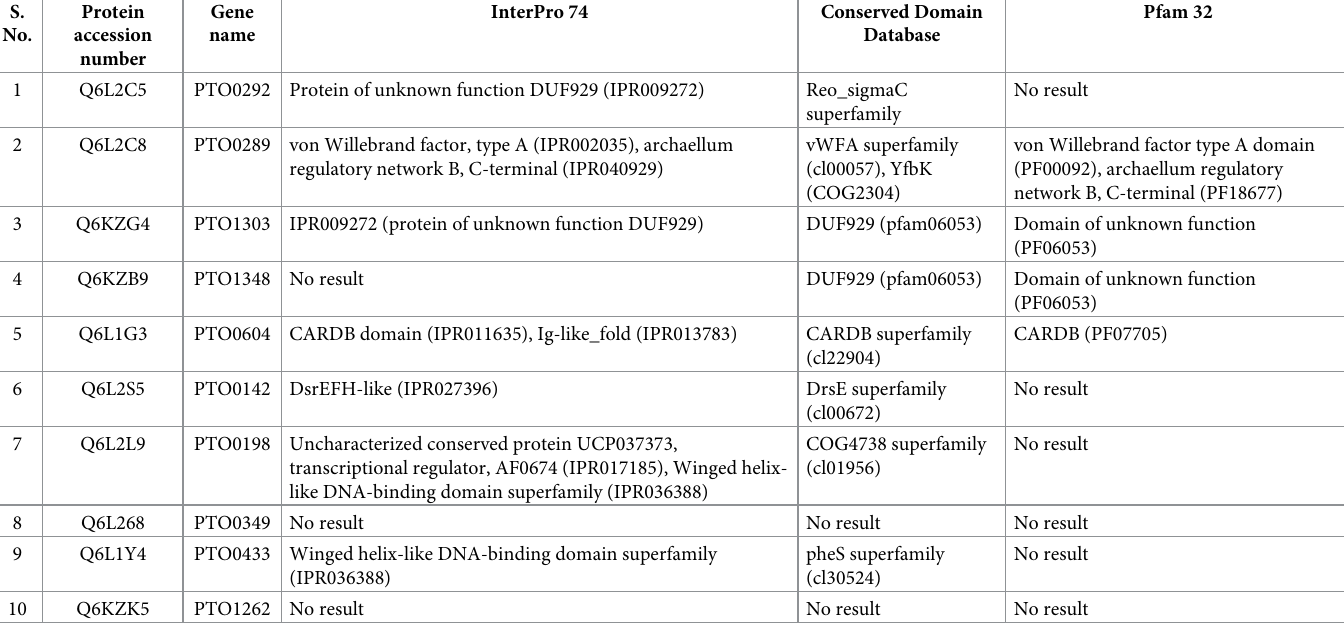
Table 2. Information about domains in the hypothetical/uncharacterized proteins in P . torridus secretome discerned using InterPro 74, Conserved Domain Data- base (CDD) and Pfam 32. S.